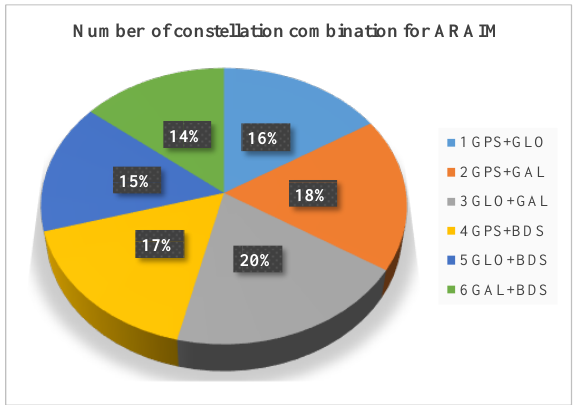
Figure 7. Selection of constellation combination in one sidereal day.